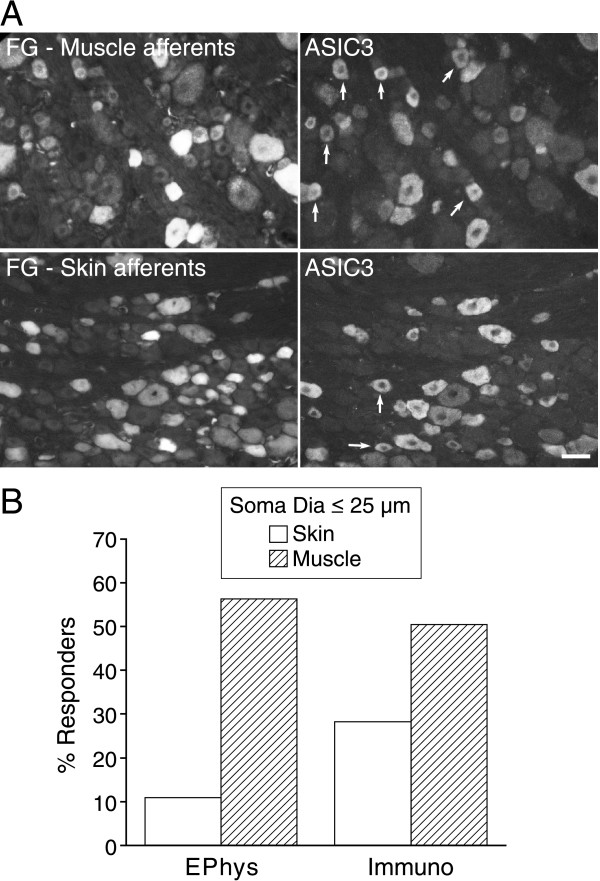
Muscle nociceptors more likely express ASIC3 than do skin nociceptors. A, Photomicrographs on the left and right are the same DRG section photographed for ASIC3 immunoreactivity (right) and fluorogold (left) that was retrogradely transported from injections into muscle (top) or skin (bottom). Arrows indicate cells that are 25 μm or smaller and contain both fluorogold and ASIC3 immunoreactivity. Scale bar, 40 μm. B, The percent of small (<25 μm) muscle or skin afferents that stain for ASIC3 (Immuno) or exhibit more than 0.3 nA of current evoked by a step to pH 6.8 from pH 7.4 (Ephys). 37 and 32 small neurons were recorded for skin and muscle, respectively. 117 and 113 small neurons were counted for skin and muscle immunocytochemistry.